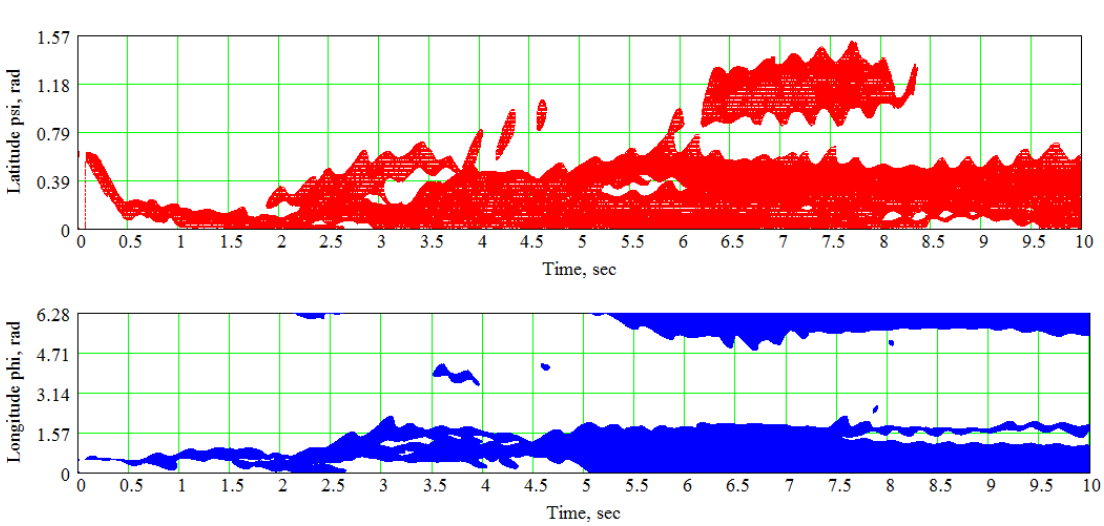
Figure 16. The special coordinates ψ ( top ) and φ ( bottom ) of the scroll wave filaments.